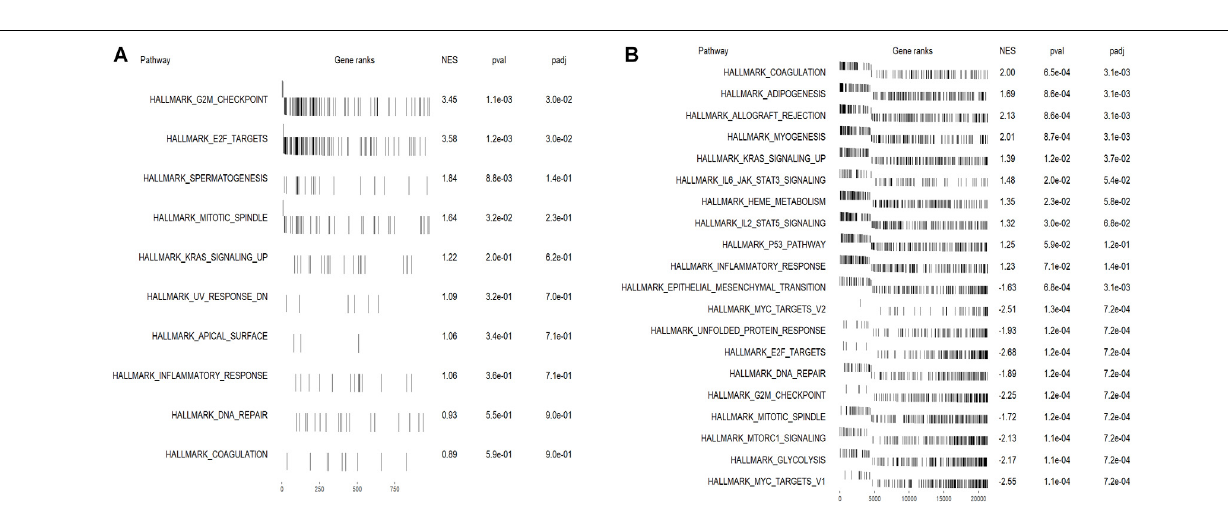
group was significantly worse than that of the low-risk one ( p < 0.0001) ( Figure 3C ). Also, the AUC plot